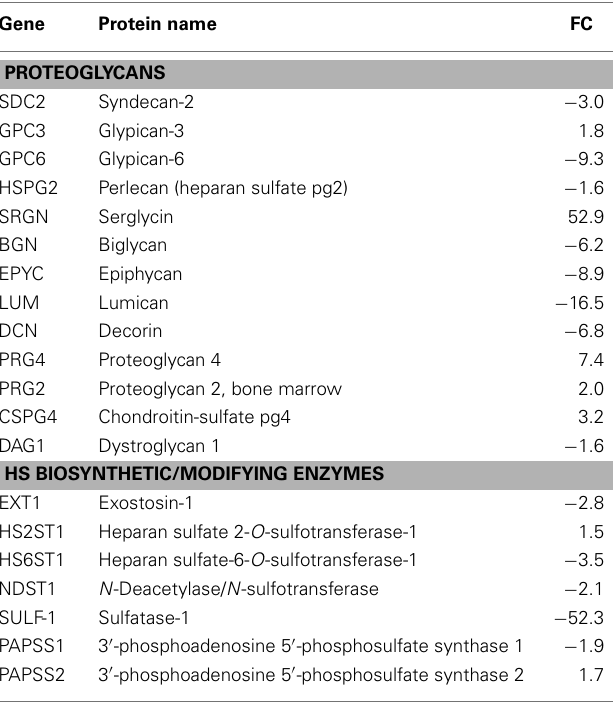
Table 1 | List of genes encoding proteoglycans and heparan sulfate biosynthetic enzymes affected by syndecan-1 overexpression in a mesothelioma cell line.